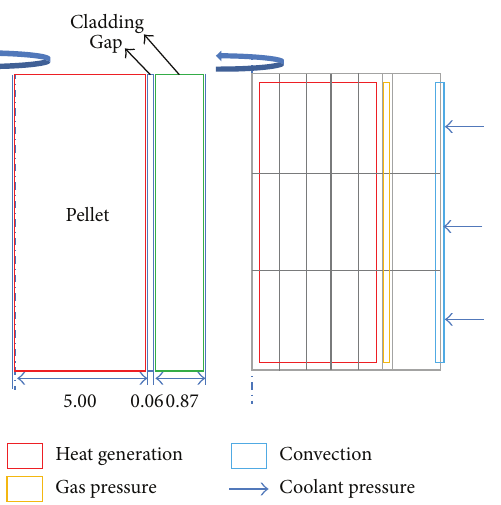
Figure 9: Temperatures changes at pellet center and cladding outer surface along the time.